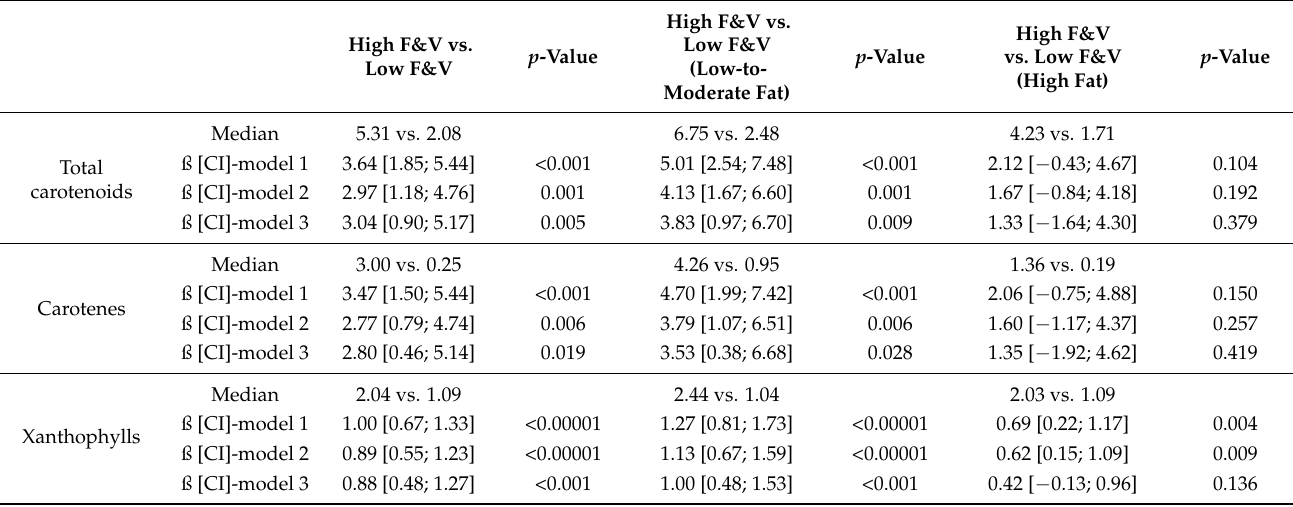
Table 2. Differences in total carotenoid, carotenes and xanthophylls plasma concentrations ( µ mol/L) between F&V consumption